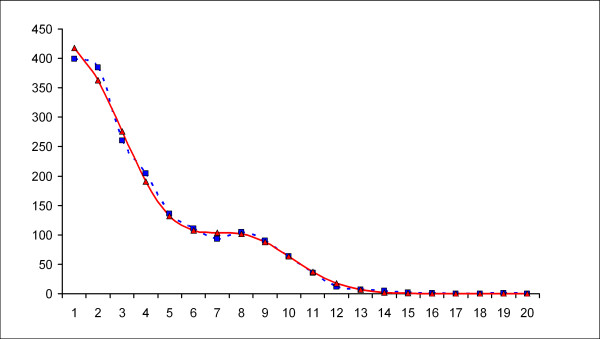
Representation of Z-distribution. The empirical distribution of the absolute value of the log-ratio of logarithms of intensities (Z) of all the signals recorded from the analyzed arrays is represented. On the x-axis the value of the variable Z is plotted; on the y-axis the value of the density function of the variable Z probability is reported. The Z-distribution appears as a bimodal density with two peaks, and it can be decomposed into two normal distributions: one with positive mean (see the peak on the right), representing the distribution of those SNPs with very different intensity values for the two alleles (homozygous genotypes), and the other with mean zero (see the peak on the left), representing the distribution of those SNPs with similar intensity values for both the alleles (heterozygous genotypes). The bold line (with filled triangles) represents the best fitting to a mixture of normal distributions obtained through an E-M algorithm, while the dashed line (with open squares) represents the real data.